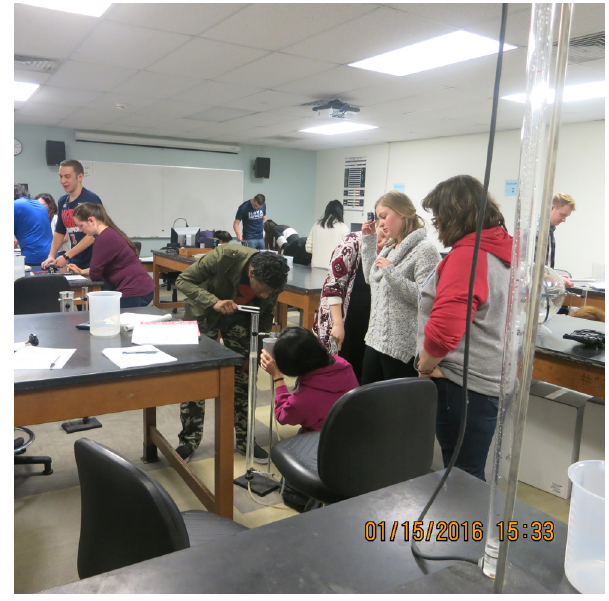
Fig. 1. Students explore sound waves in a workshop/studio style.